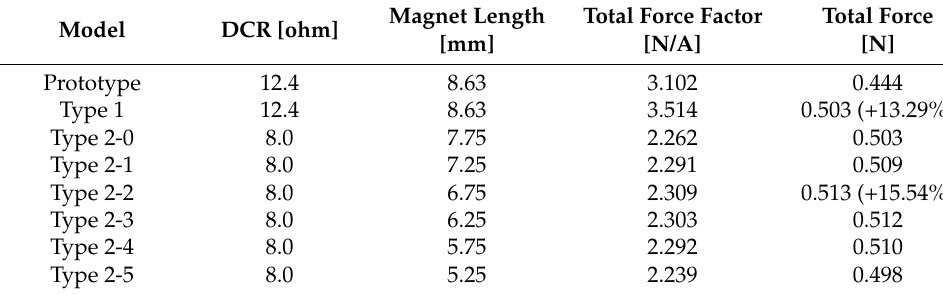
Figure 7. Magnet length optimization. Table 2. Force factor and force comparison.